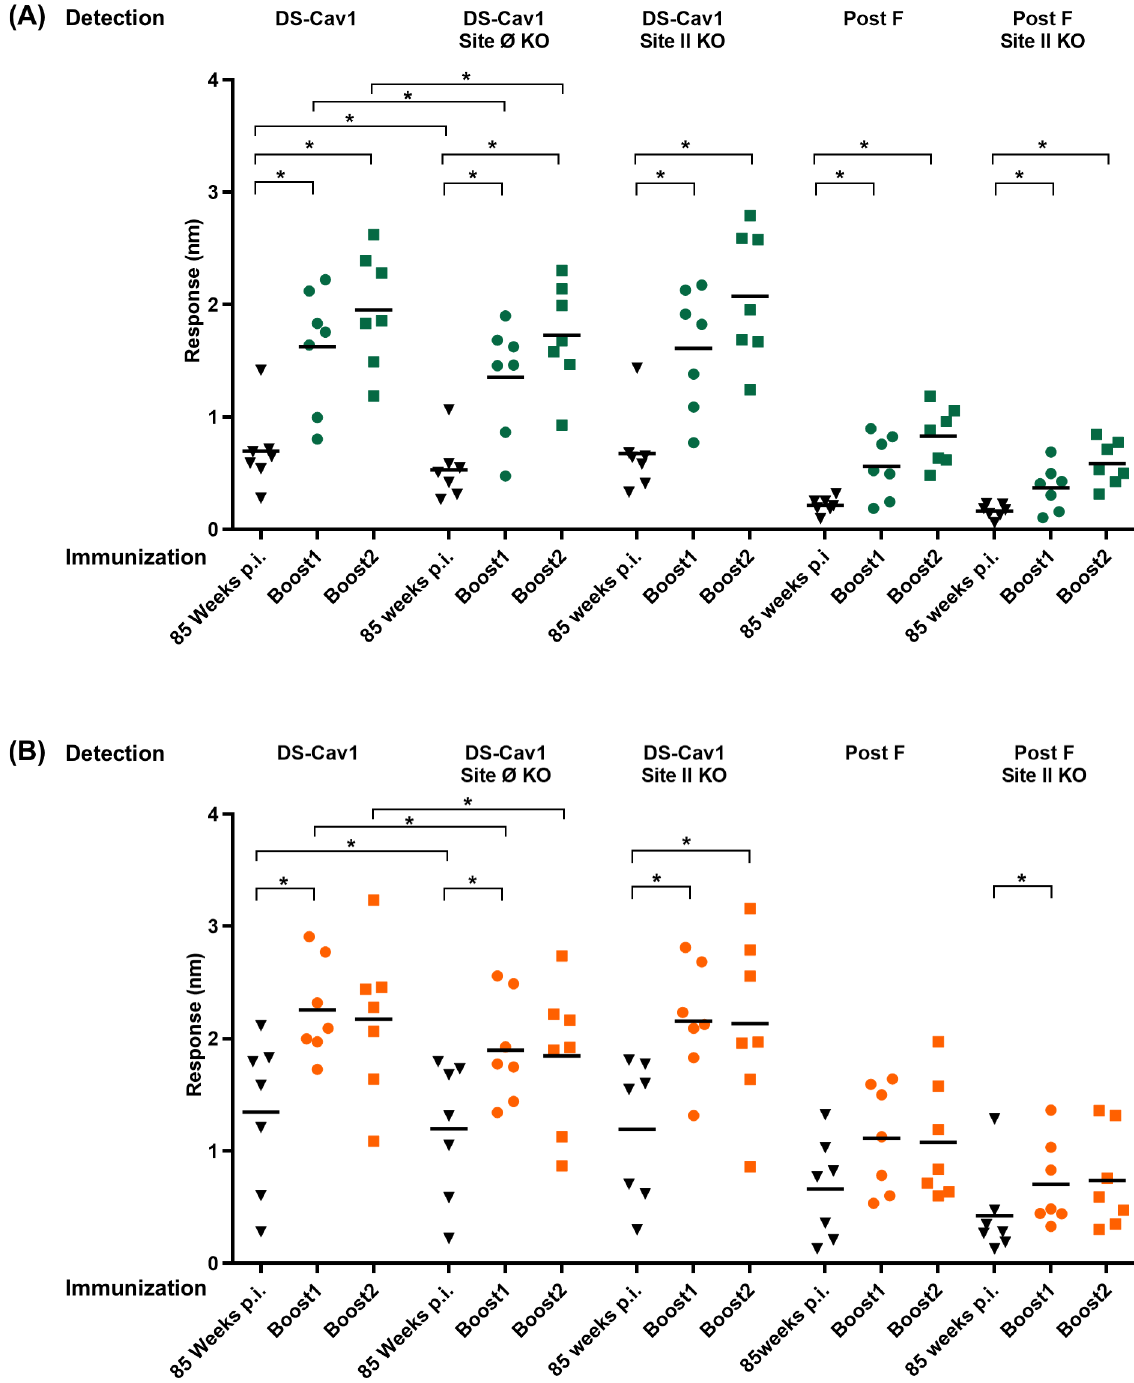
Fig 5. Boost by adjuvanted RSV F DS-Cav1can focus the RSV immune response to antigenic site Ø and II in elderly mice. Pre-immunized elderly mice (~85 weeks wait) were administered (A) DS-Cav1 formulated with SAS + Carbopolor (B) DS-Cav1 formulated with Alum and recognitionof DS-Cav1,DS-Cav1 site Ø KO, DS-Cav1 site II KO, Post F and Post F site II KO probesby sera for all immunizedmice assessed. Scatter plots show the geometricmean. p values were determinedby two-tailed Wilcoxon matched-pairs signed rank test, p = > 0.05 (ns); p < 0.05 ( * ). Associatedraw data is reportedin S5 Table.